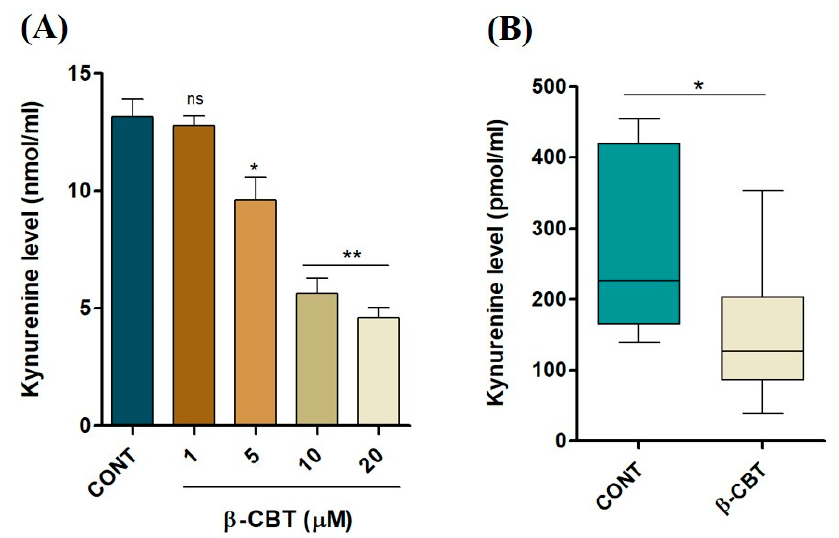
Figure 8. Effect of β -CBT on Kyn level in PC-3M in cell culture and in nude mice plasma xenografted with PC-3M-Luc cells. ( A ) Dose–response effects of the β -CBT treatments on the level of Kyn in in vitro cultured PC-3M cells. Bar graphs represent the mean Kyn level (± SD) at indicated concentrations. ( B ) Comparison of Kyn level in vehicle-treated control versus β -CBT-treated mice plasma. Data represent median, minimum and maximum values. * indicates statistical significance at p < 0.05 and ** at p < 0.01.